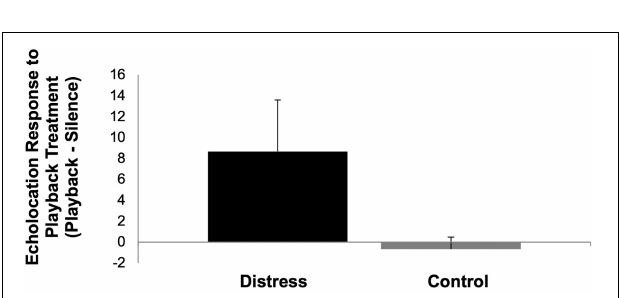
FIGURE 3 | Effect of playback treatment on echolocation calling behavior in Brachyphylla nana shown as the mean change in responsiveness (echolocation calls during playback period—silent period). Error bars represent the standard error of the